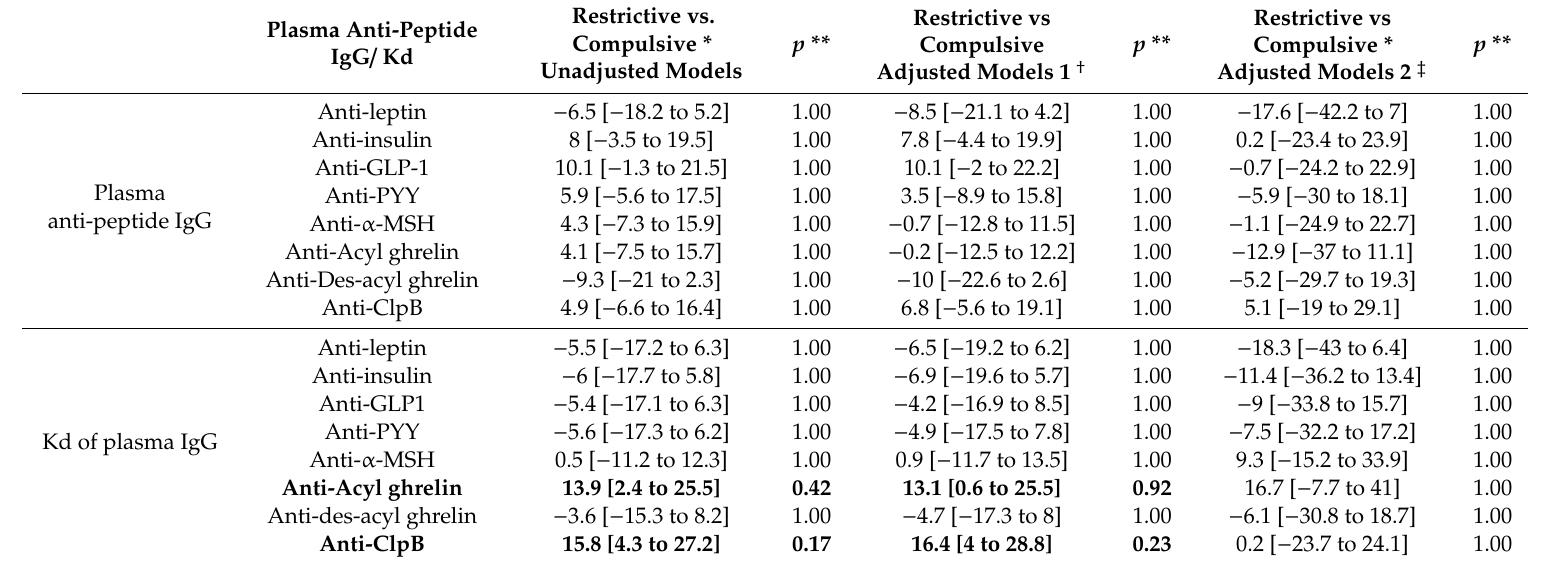
Table 3. Linear models explaining plasma IgG concentrations of peptides associated with food intake according di ff erent adjustments. Restrictive vs. Plasma Anti-Peptide IgG / Kd